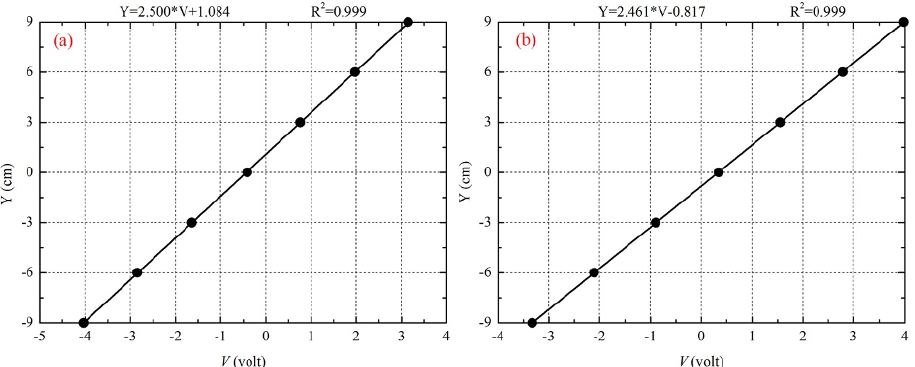
Figure A2. Calibration of the probes. ( a ) Probe 1. ( b ) Probe 2.